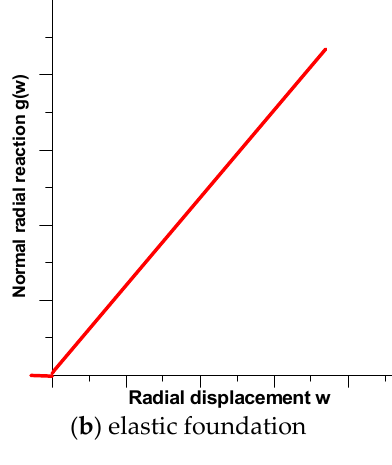
Figure 3. Forms of normal reaction S N.